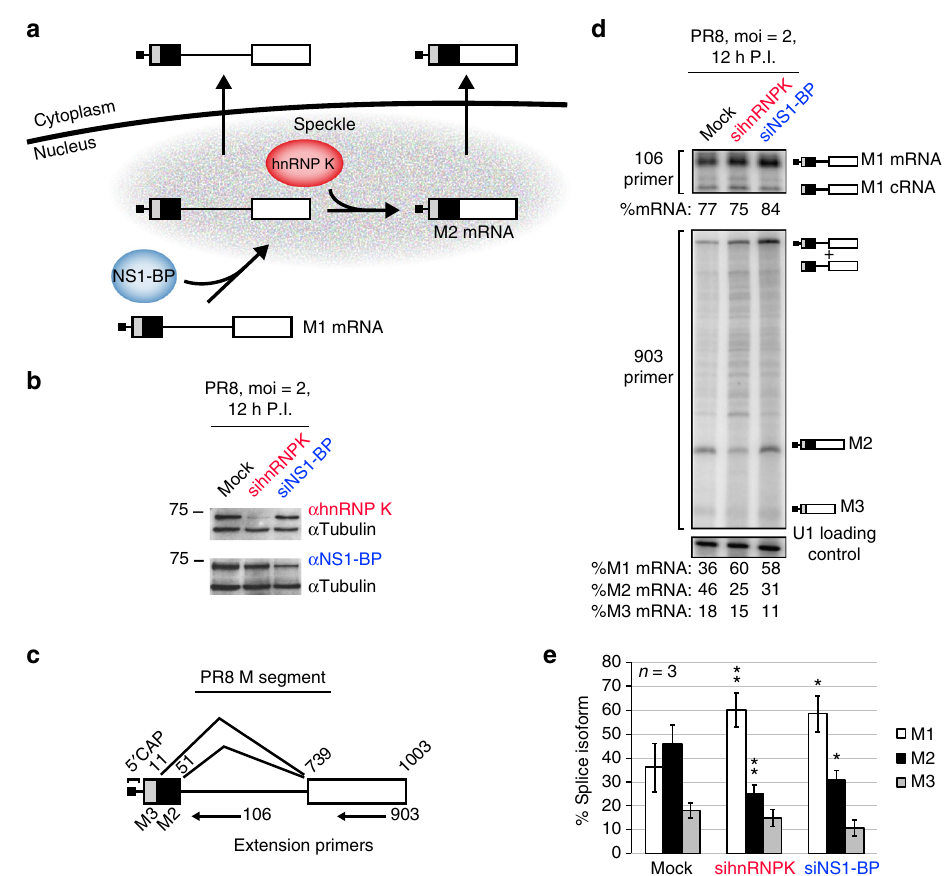
Fig. 1 Host proteins hnRNP K and NS1-BP regulate IAV PR8 M segment splicing. a Model for hnRNP K and NS1-BP regulated M segment splicing based on previous studies 6,7 . b Immunoblots of A549 whole cell extract 12 h post PR8 infection in the context of mock, hnRNP K or NS1-BP siRNA knockdown. Molecular weights are indicated to left of each blot. c Diagram of IAV PR8 M segment mRNA with possible splice isoforms and extension primer positions labeled. Boxes denote exons and the line denotes an intron. M3 and M2 indicate potential 5 ′ ss and numbers indicate nucleotide position. d Primer extension of PR8 M segment antisense RNA after 12 h infection in A549 cells at moi = 2. Cells were mock transfected or treated with 50 nM siRNA targeted at hnRNP K or NS1-BP. Extension primers used are indicated on the left and band identities on the right of the gel image. Uncropped gels shown in Supplementary Fig. 5. e Quanti fi cation of mRNA primer extension products represented as percentage signal of each isoform relative to signal of total isoforms (M1 + M2 + M3). Values are means ± s.d. from three independent experiments. For all experiments in manuscript, a minimum of 3 experiments were performed to insure appropriateness of statistical tests. Statistical signi fi cance was determined via two-tailed student ’ s t test, where * p < 0.1 and ** p < 0.05 when comparing mock vs siRNA